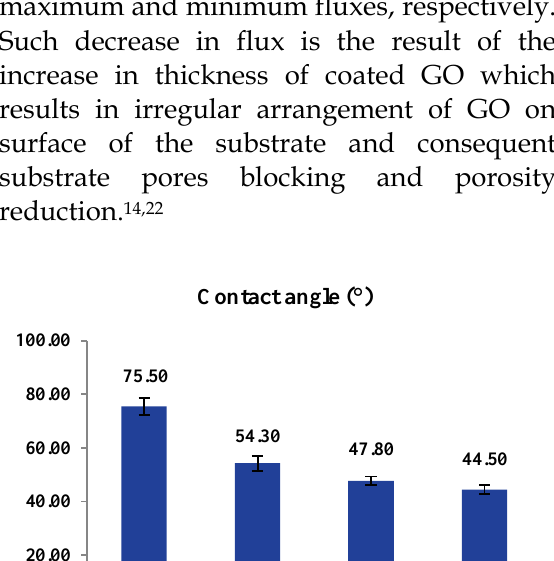
Membranes Type contact angle of the fabricated membranes Several studies also showed no significant correlation between membrane flux and thickness of coated GO. 28,29 This difference may be due to the characteristics of the substrate and the binder used in the preparation of GO suspension in this study. Pure water flux